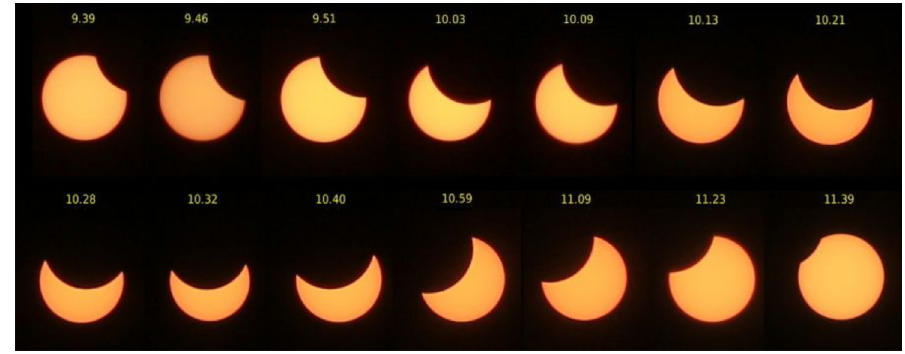
Figure 4. Set of photographs of various phases of the March 20, 2015, eclipse as observed in Pescara (central Italy). The reported timing is in UT+1 to fit the local Italian time. Photo from http://www.zazoom.it/newsnotizia/post/305603/eclissi-solare-del-2032015-osservata-da- terra-e-dallo-spazio.